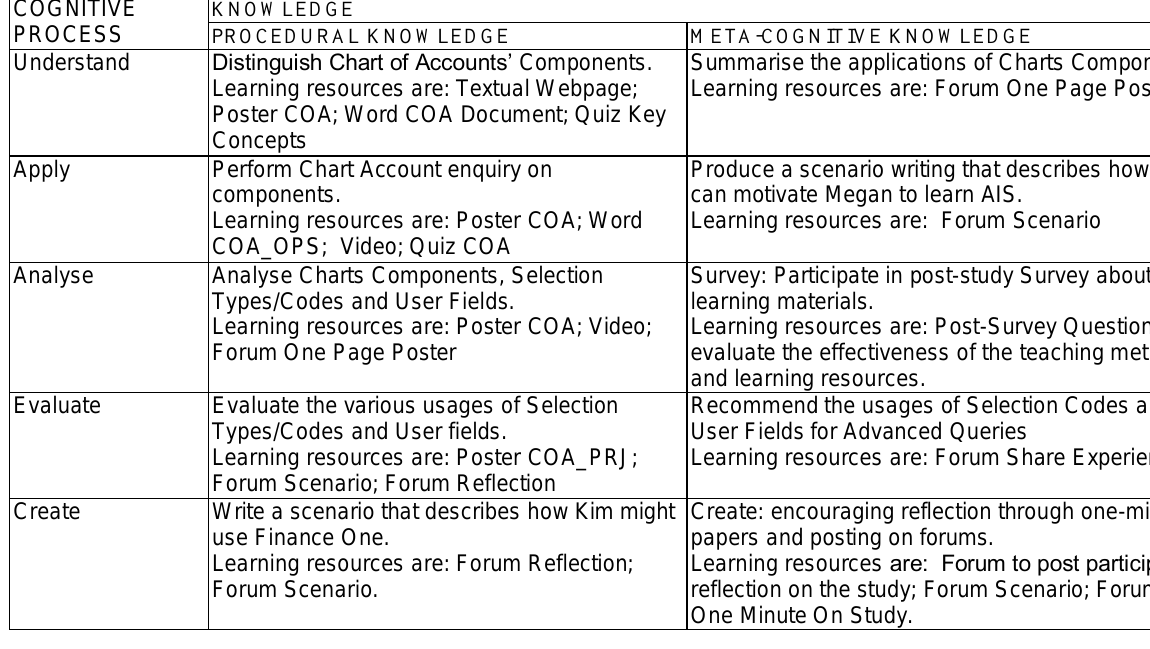
Table 7. Procedural and Meta-Cognitive